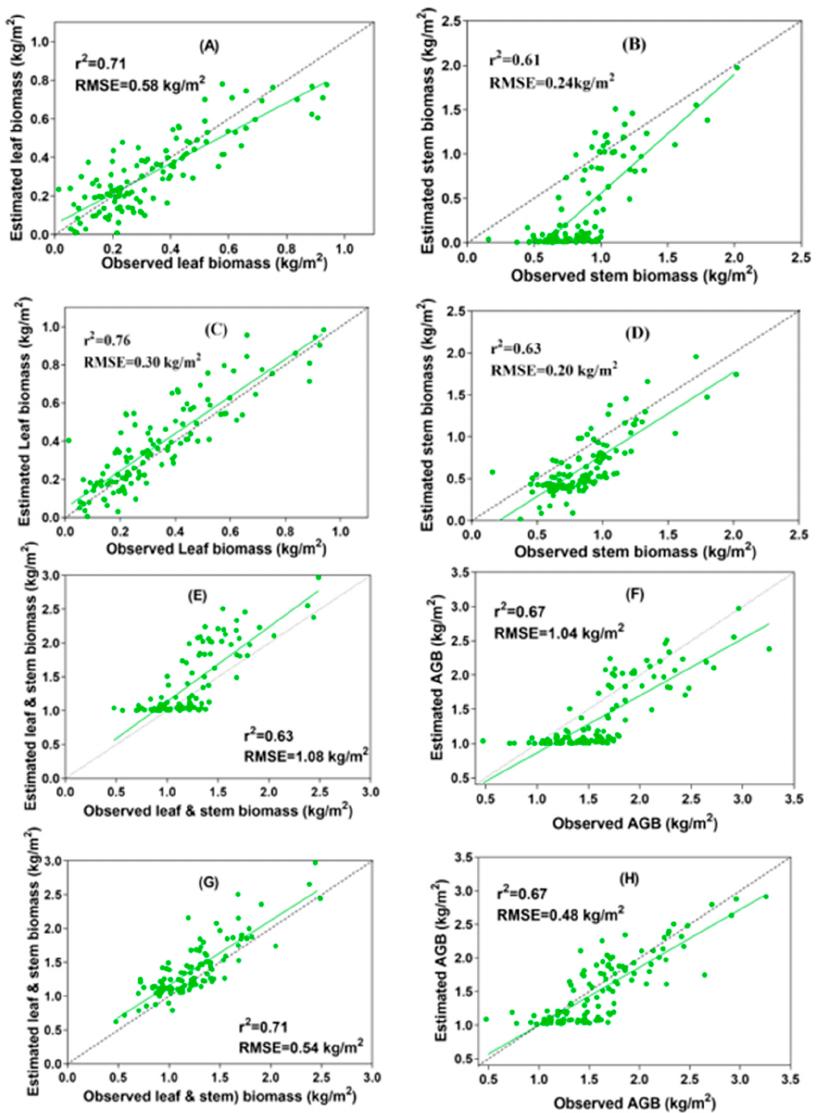
Figure 5. Comparisons between measured and estimated biomass components from single-target Gaussian process regression (SGPR) for ( A ) leaf biomass using SOMVI, ( B ) stem biomass using SOMVI, ( C ) leaf biomass using SODVI, ( D ) stem biomass using SODVI, ( E ) leaf and stem biomass using SOMVI, ( F ) AGB using SOMVI, ( G ) stem and Leaf biomass using SODVI, and ( H ) AGB using SODVI. The green line represents a linear regression between the observed and estimated values, and the dashed line represents the 1:1 line.